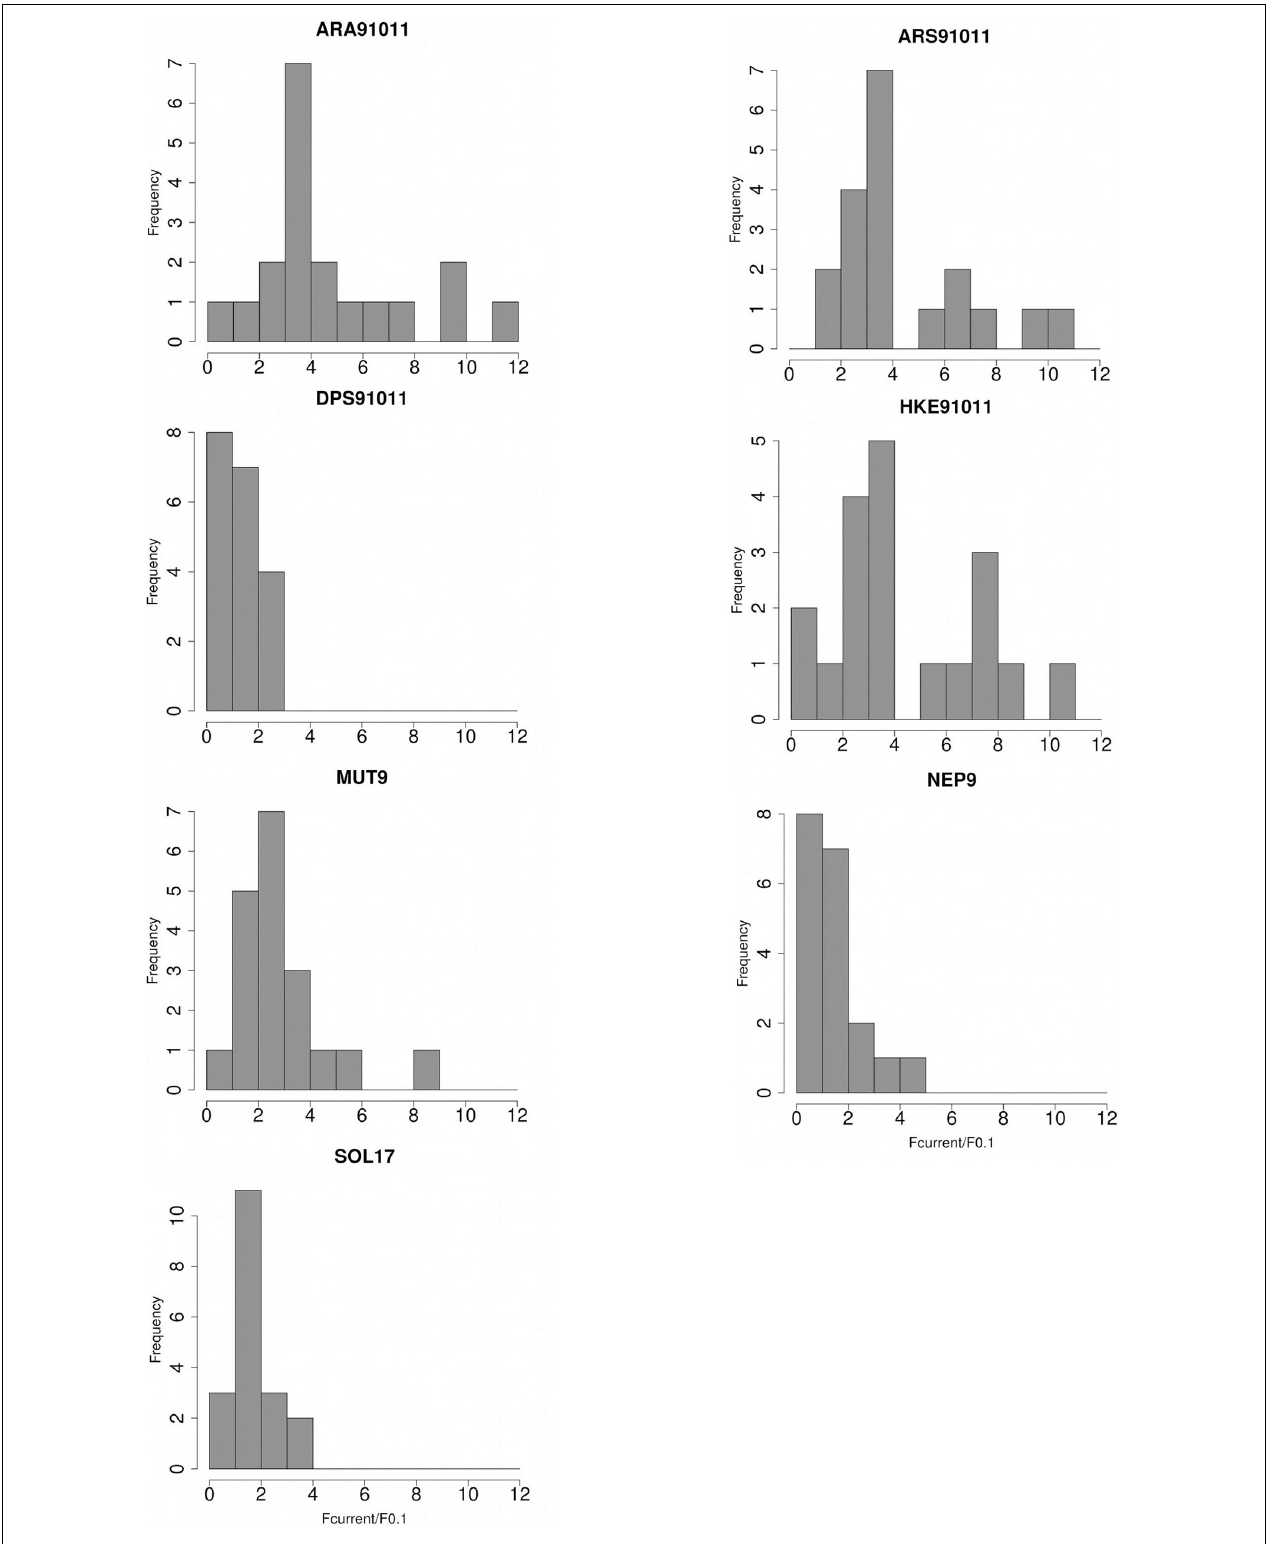
FIGURE 2 | Distributions of the ratios between F curr and F 0 . 1 derived from 18 different natural mortality vectors for the seven stocks analyzed: Blue and red shrimp (ARA), Giant red shrimp (ARS), Deep-water rose shrimp (DPS) and European hake (HKE) in GSAs 9,10, and 11, Red mullet (MUT) and Norway lobster (NEP) in GSA 9 and Common sole (SOL) in GSA